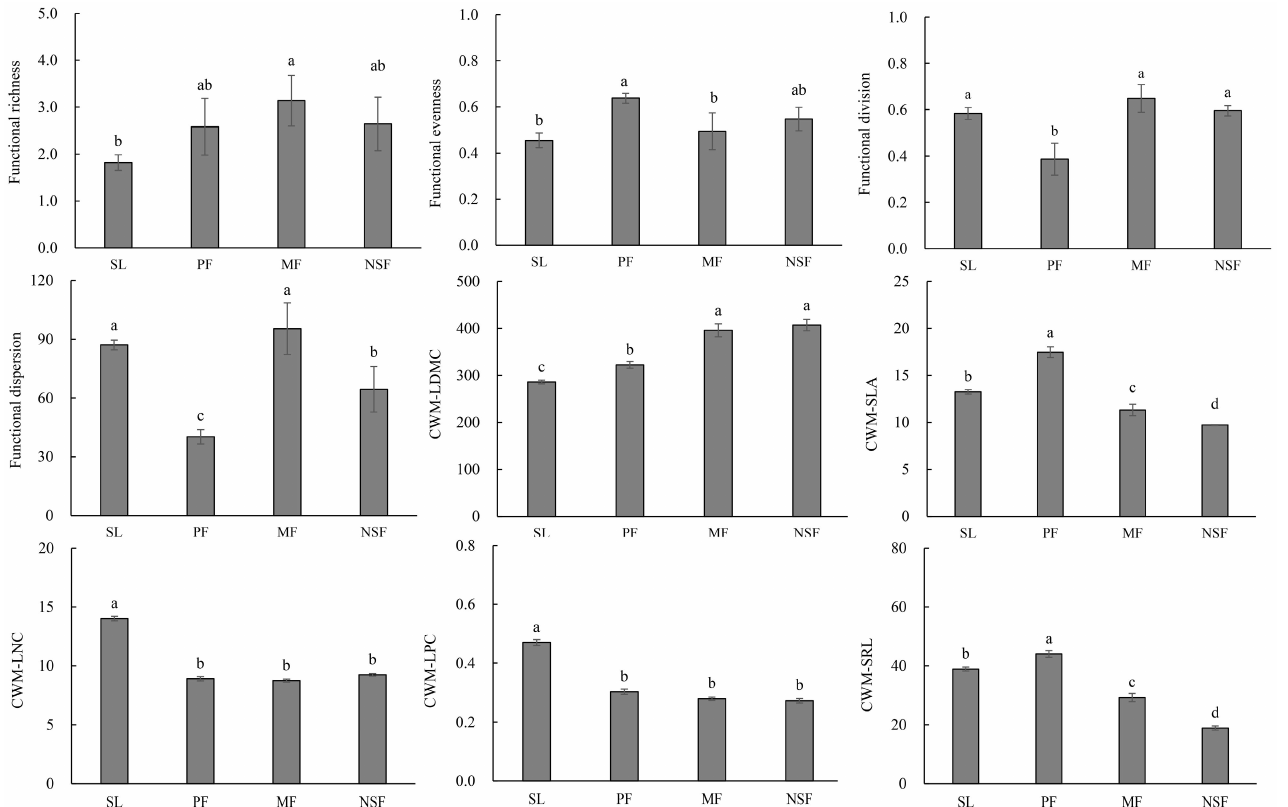
Figure 2. Functional characteristics (FD and CWMs) in four vegetation restoration types. Different letters indicate significant differences among the four restoration types at the 0.05 level.The CWM values of functional traits showed different distributions depending on the functional traits (Figure 2). CWM- LDMC tended to increase with the development of community structure complexity, with CWM-LDMC values in MF and NSF significantly higher than those in PF and SL. For SLA and SRL, the order of values of CWM was PF > SL > MF > NSF, with significant differences among all four communities. SL